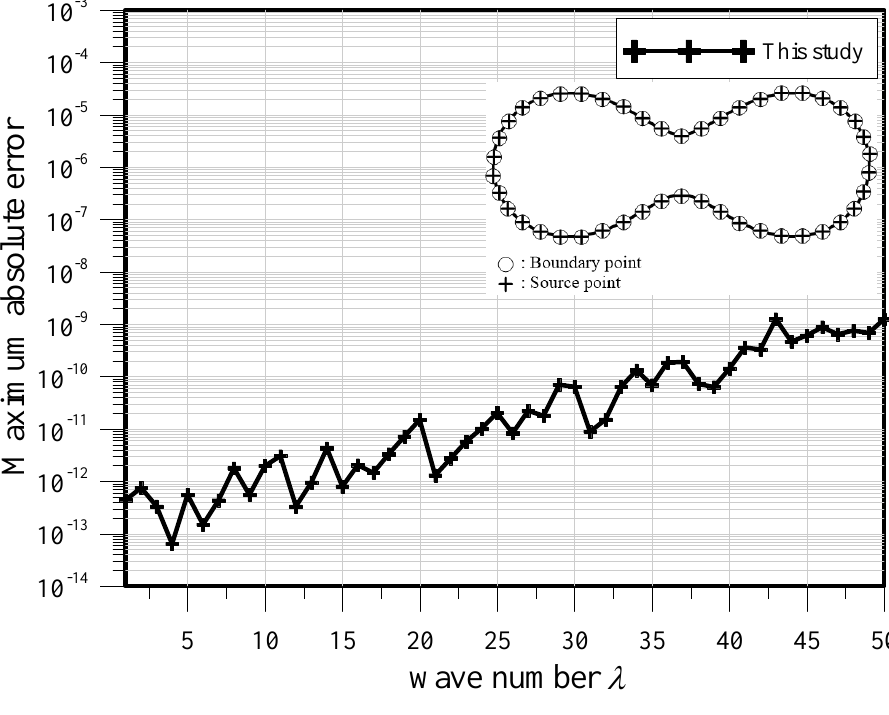
Figure 10. MAE versus the wave number λ .